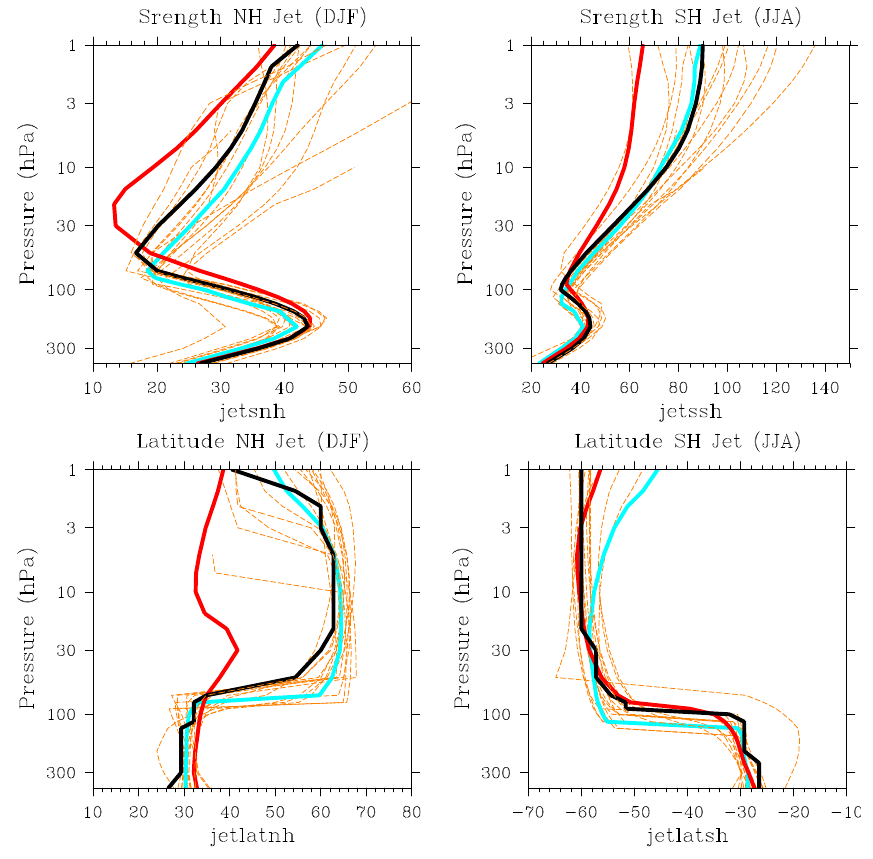
Fig. 3. Strengths (m s − 1 ) and latitudes of the maximum of the climatological zonal wind in DJF (first column) and JJA (second column). Climatologies (1980–2001) are for ERA-40 (cyan line), CNRM-ACM (red line), CNRM-CCM (black line), and CCMVal-2 REF-B1 models (dashed orange lines).